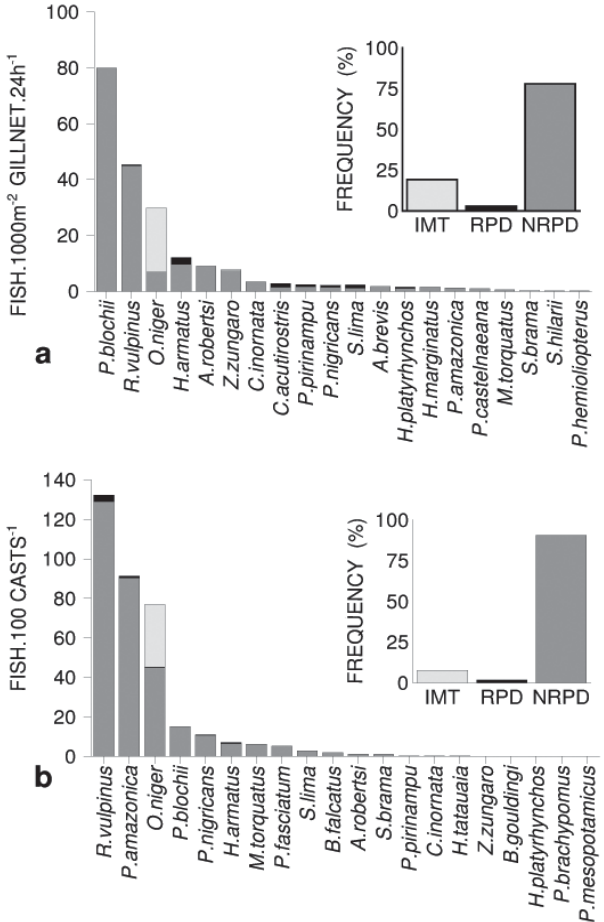
Fig. 2. Frequency of gonadal maturation stages (%, smaller panels) and abundance of migratory species (females) ac- cording to gonadal maturation stages downriver (a) and in the ladder (b) at Lajeado Dam. IMT = immature individuals; RPD = reproducing; and NRPD =